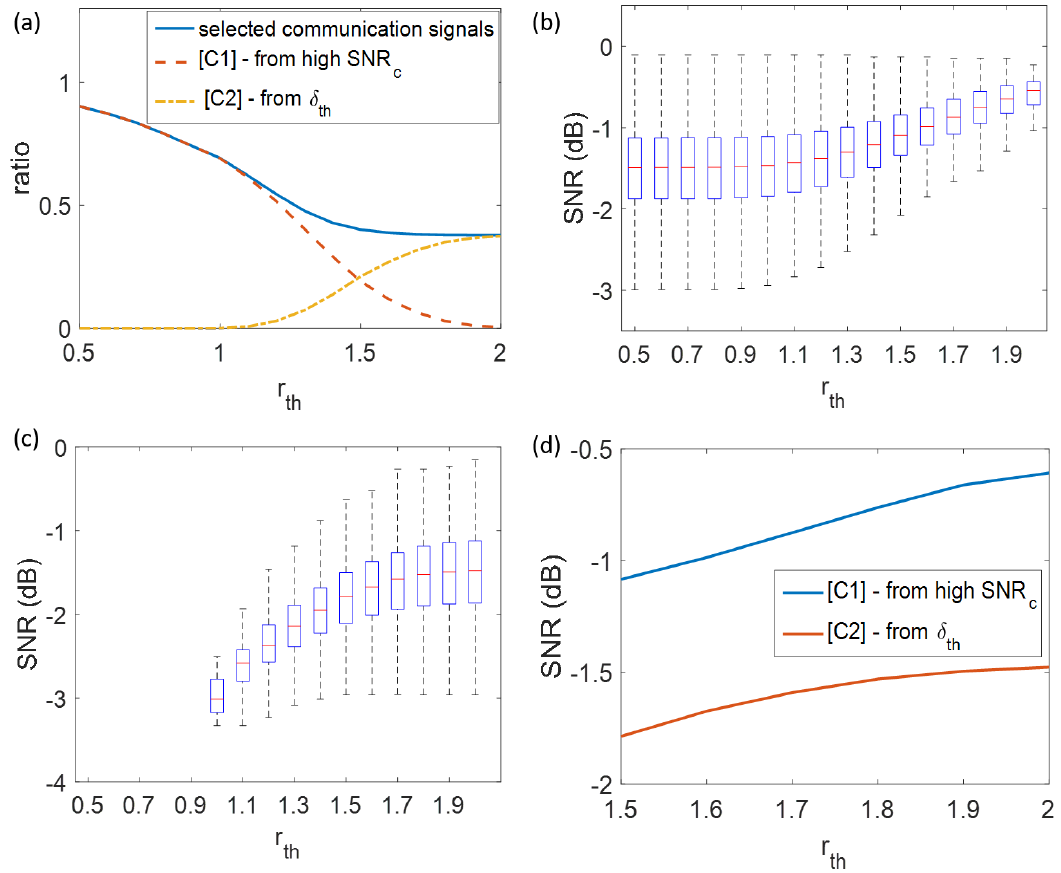
Figure 6. Analysis of confidence factor threshold r th : ( a ) selected ratio of communication signals; ( b ) distribution of SNR of [C1] (the selected communication signals due to high SNR c ); ( c ) distribution of SNR of [C2] (the selected communication signals due to large δ ); and ( d ) average of SNR of [C1] and